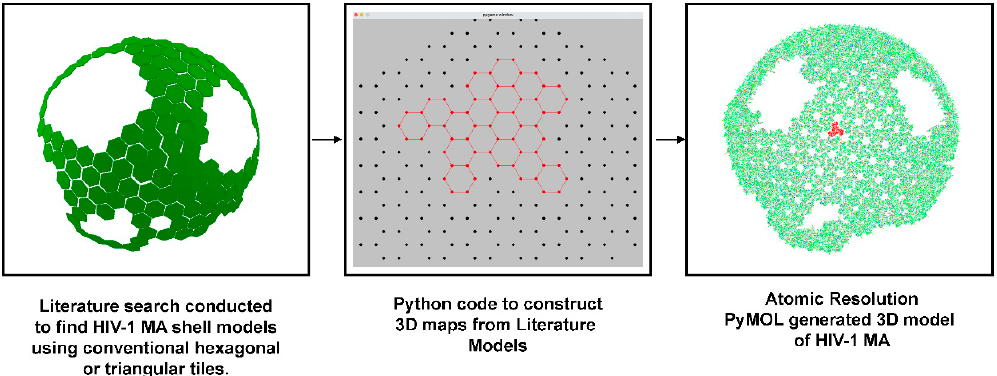
Figure 1. HIV-1 Model Pipeline. HIV-1 MA Shell Models from Literature. A recent literature search was conducted to find conventional HIV-1 shell models [8–11]. Each green hexagon represents six trimers. Python code was used to generate 3D maps from selected literature models. PyMOL was used to generate molecularly accurate 3D hexagonal models of the HIV-1 MA shells and their trimers at atomic resolution. A trimer is highlighted in red.